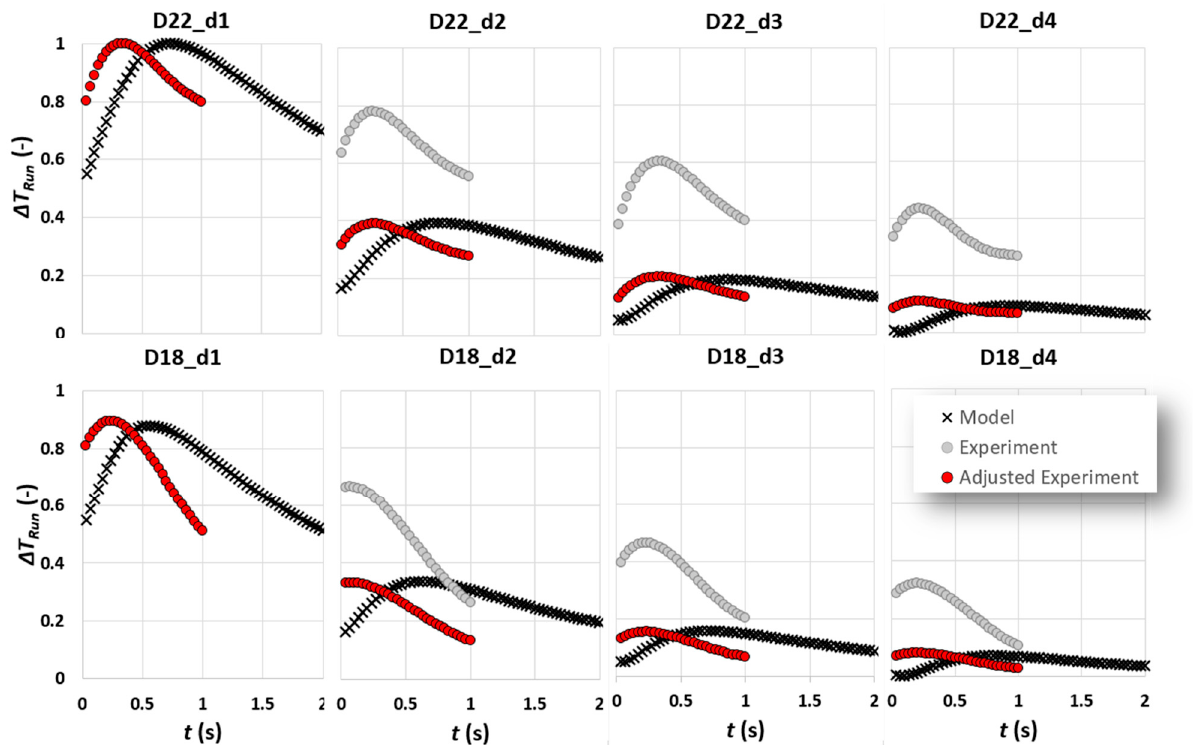
Figure 14. A comparison between experimental results, analytical model and adjusted model for defects of diameter 22 and 18 mm for various depths.